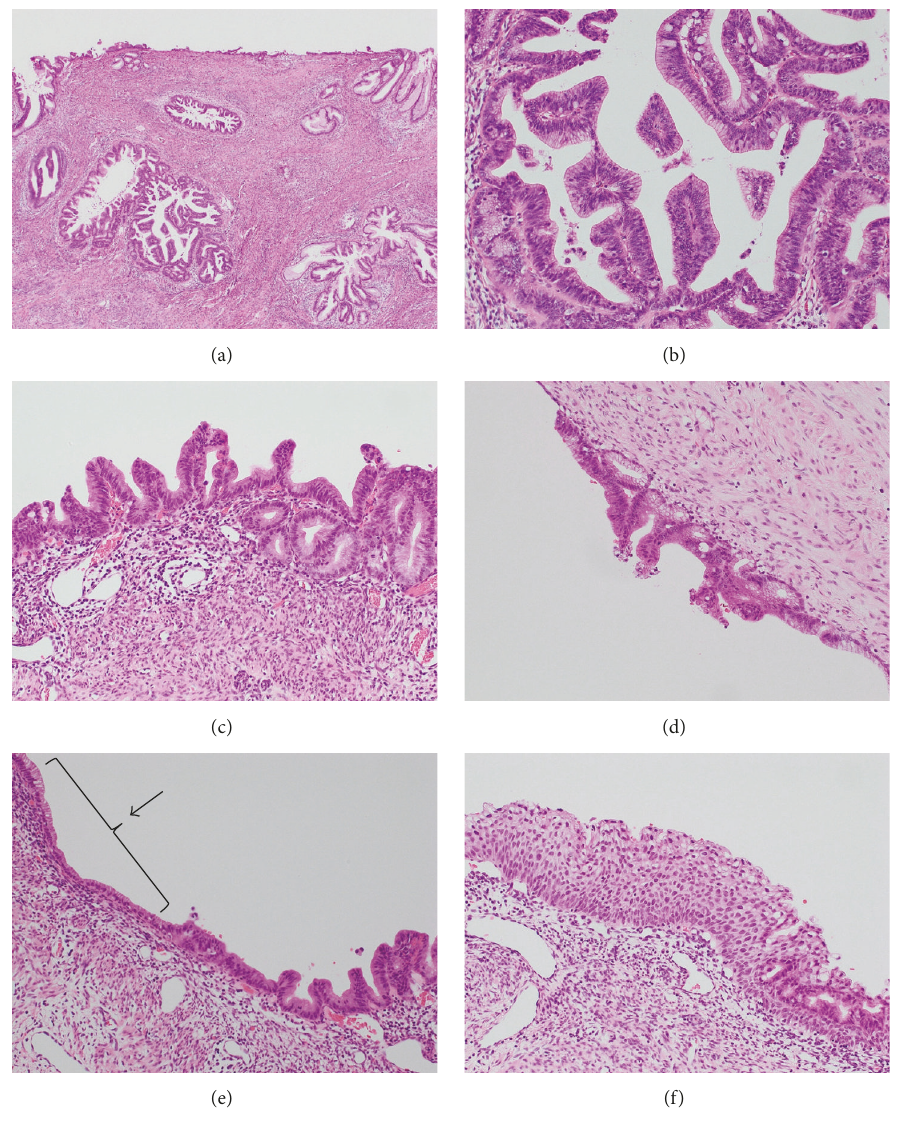
Figure 4: Intraepithelial lesions. (a) H-E stain. Endocervical lesions. Neoplastic epithelium replaces normal epithelium on the cervical surface and glands. (b) Neoplastic epithelium with atypical epithelial and glandular cells with nuclear irregularity, variable sizes, mitosis, and apoptosis. Some glands have abundant pale eosinophilic cytoplasm, and partial glands have intestinal differentiation with goblet cells. AIS. (c) H-E stain. Endometrial lesions. Similar lesions in the endocervical mucosa. Cytological atypia was less than Figures 4(a) and 4(b); however theyhavemildnuclearatypiaandpseudostratification.(d)H-Estain. Thelefttubemucosaisabnormalwithmildnuclearpseudostratification, hyperchromasia, and enlargement, and tumor cells had mitosis. However, dysplasia was less than AIS. (e) H-E stain. Endometrium without lobular architecture and with the characteristic “pale pink” cytoplasm that was next to AIS. Simple gastric metaplasia (as indicated by arrow). (f) H-E stain. The endometrium showed lesions of stratified mucin-producing intraepithelial lesion (SMILE) focally. The stratified epithelium contains cells with mucin vacuoles in all cell layers. Nuclear atypia and hyperchromasia figures are present.